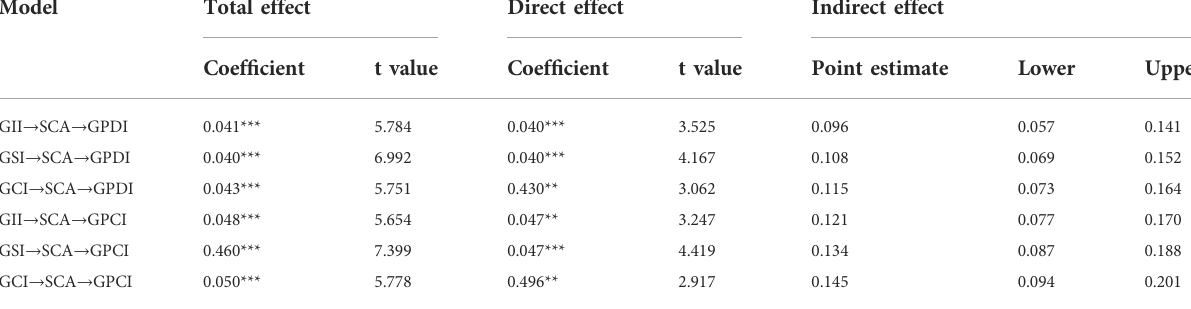
TABLE 5 Bootstrapped mediation results.